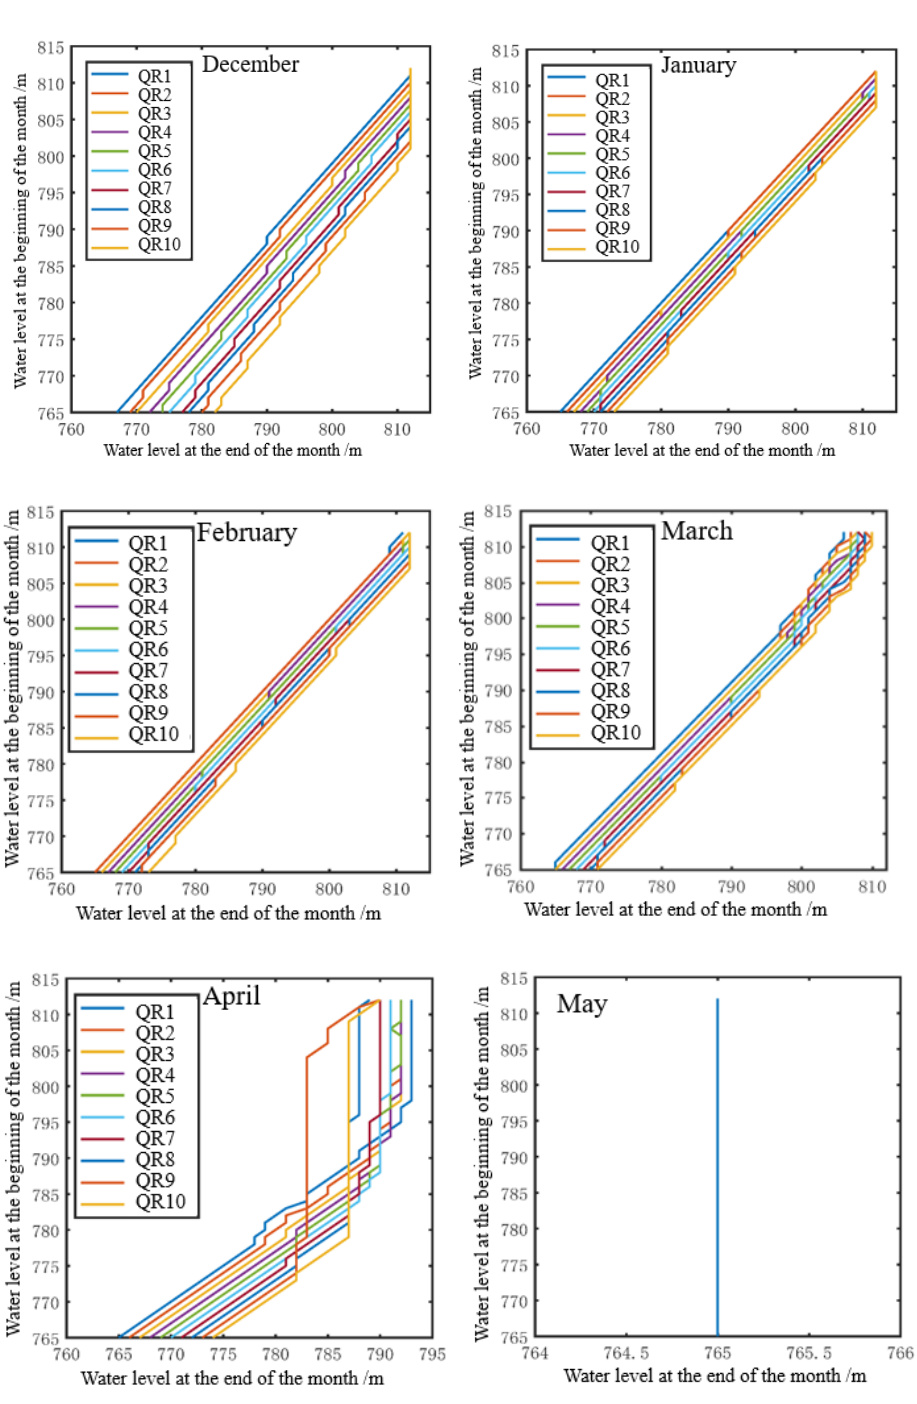
Figure 11. Results for operation of the NZD hydropower plant based on SDP.